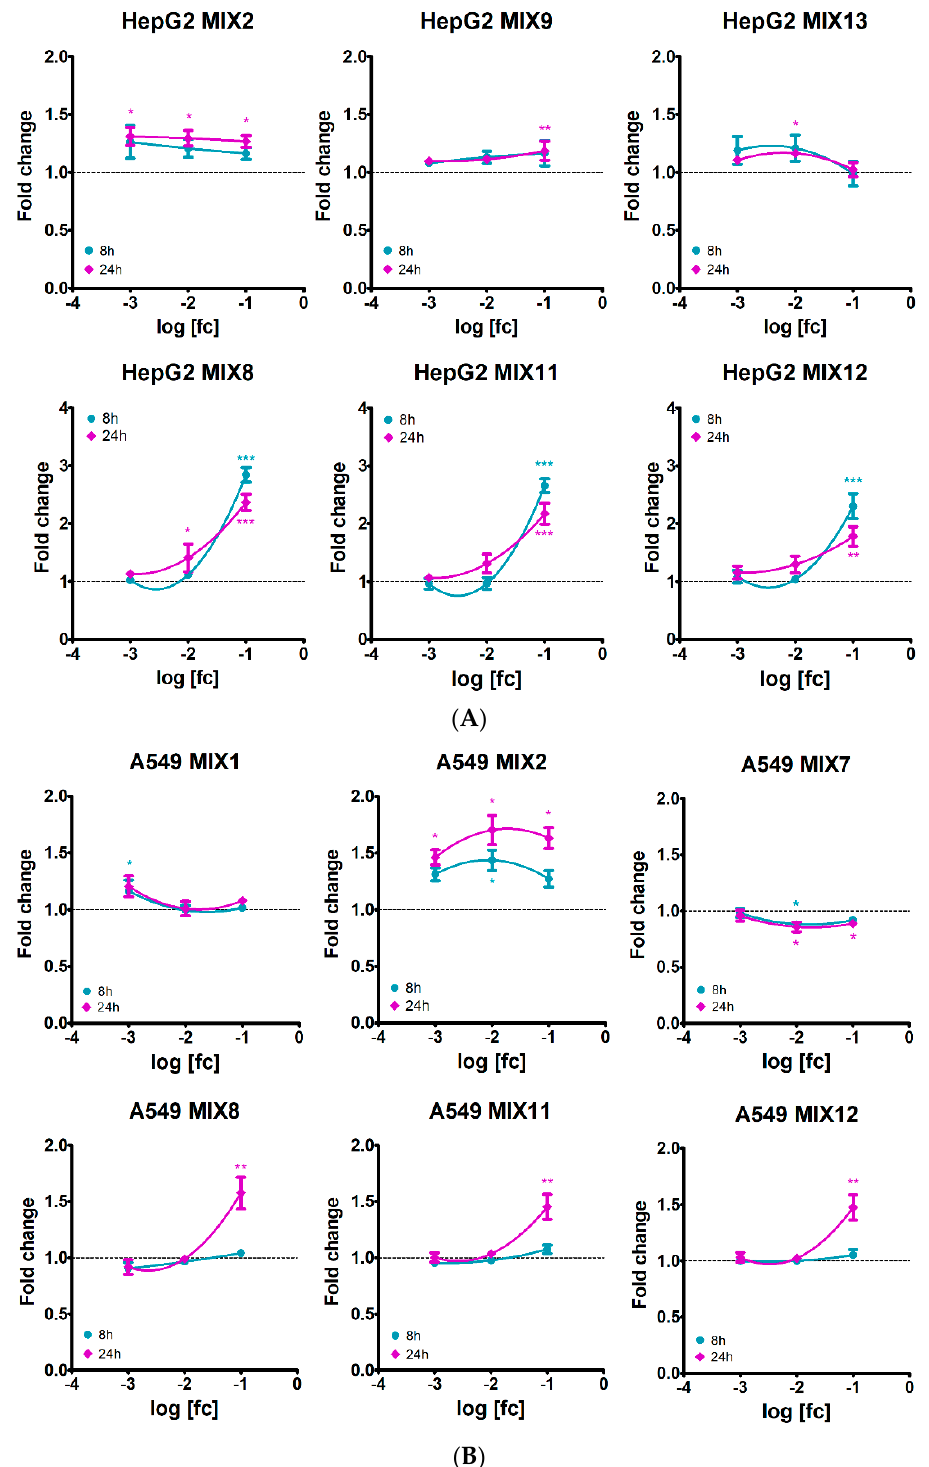
Figure 3. Dose-response curves of necrosis assessment in ( A ) HepG2 and ( B ) A549 cell lines treated with different pesticide mixtures for 8 h (dark turquoise lines) and 24 h (dark magenta lines). Concentrations are expressed as log of the field concentration [fc] dilution applied. Data represent mean fold change fluorescence signals, compared to control cells, of three independent experiments. Among the 13 pesticide mixtures tested, only graphs with significant effects are shown. Asterisks indicate the level of significance: * p < 0.05; ** p < 0.01; *** p < 0.001.